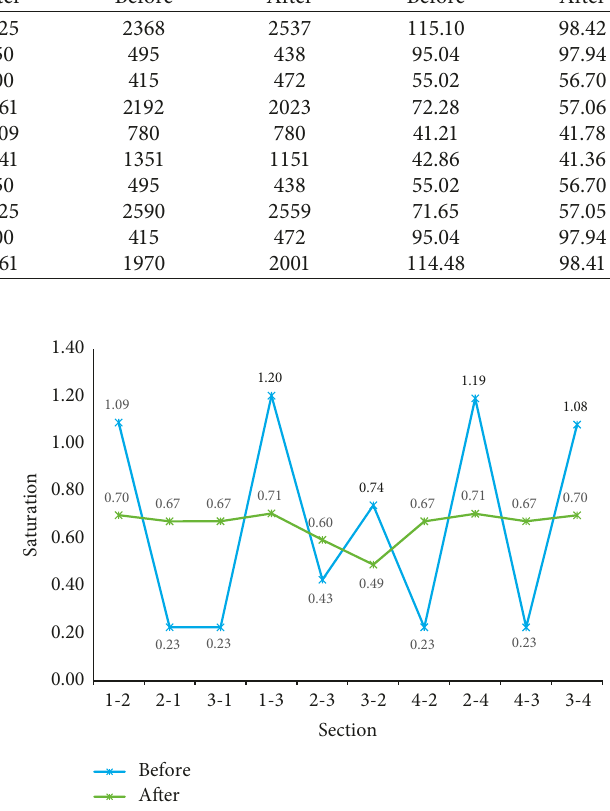
Figure 3: The capacity and flow of each section before reversible lane optimization.